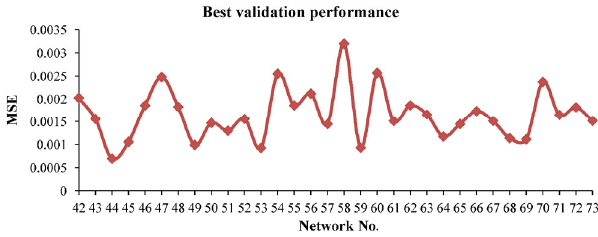
Fig. 18 Mean square error of multi hidden layer ANN archi- tectures (Network Nos. 42 − 73).